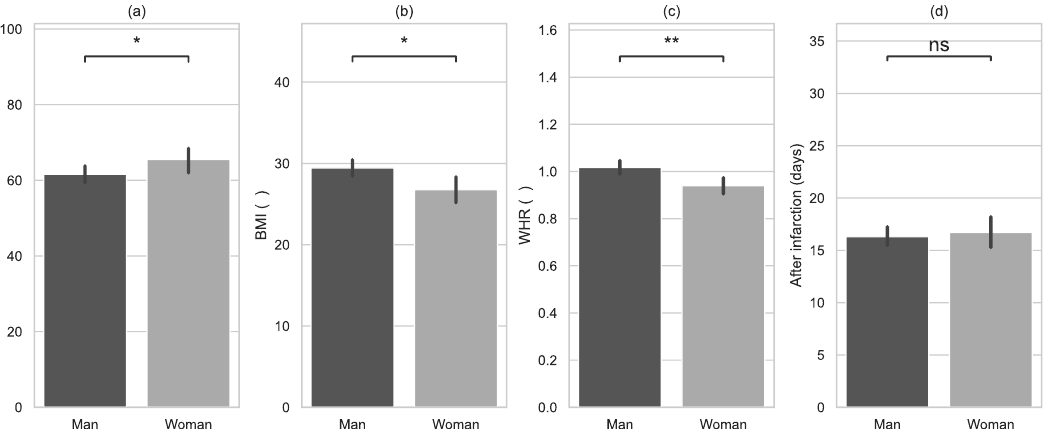
Figure 1. Characteristics of examined groups (sex) with error bars and p -value annotation legends: ( a ) age, ( b ) body mass index (BMI), ( c ) waist-to-hip ratio (WHR), ( d ) number of days after infarction and onset of rehabilitation. *: 0.01 < p ≤ 0.05; **: 0.001 < p ≤ 0.01.